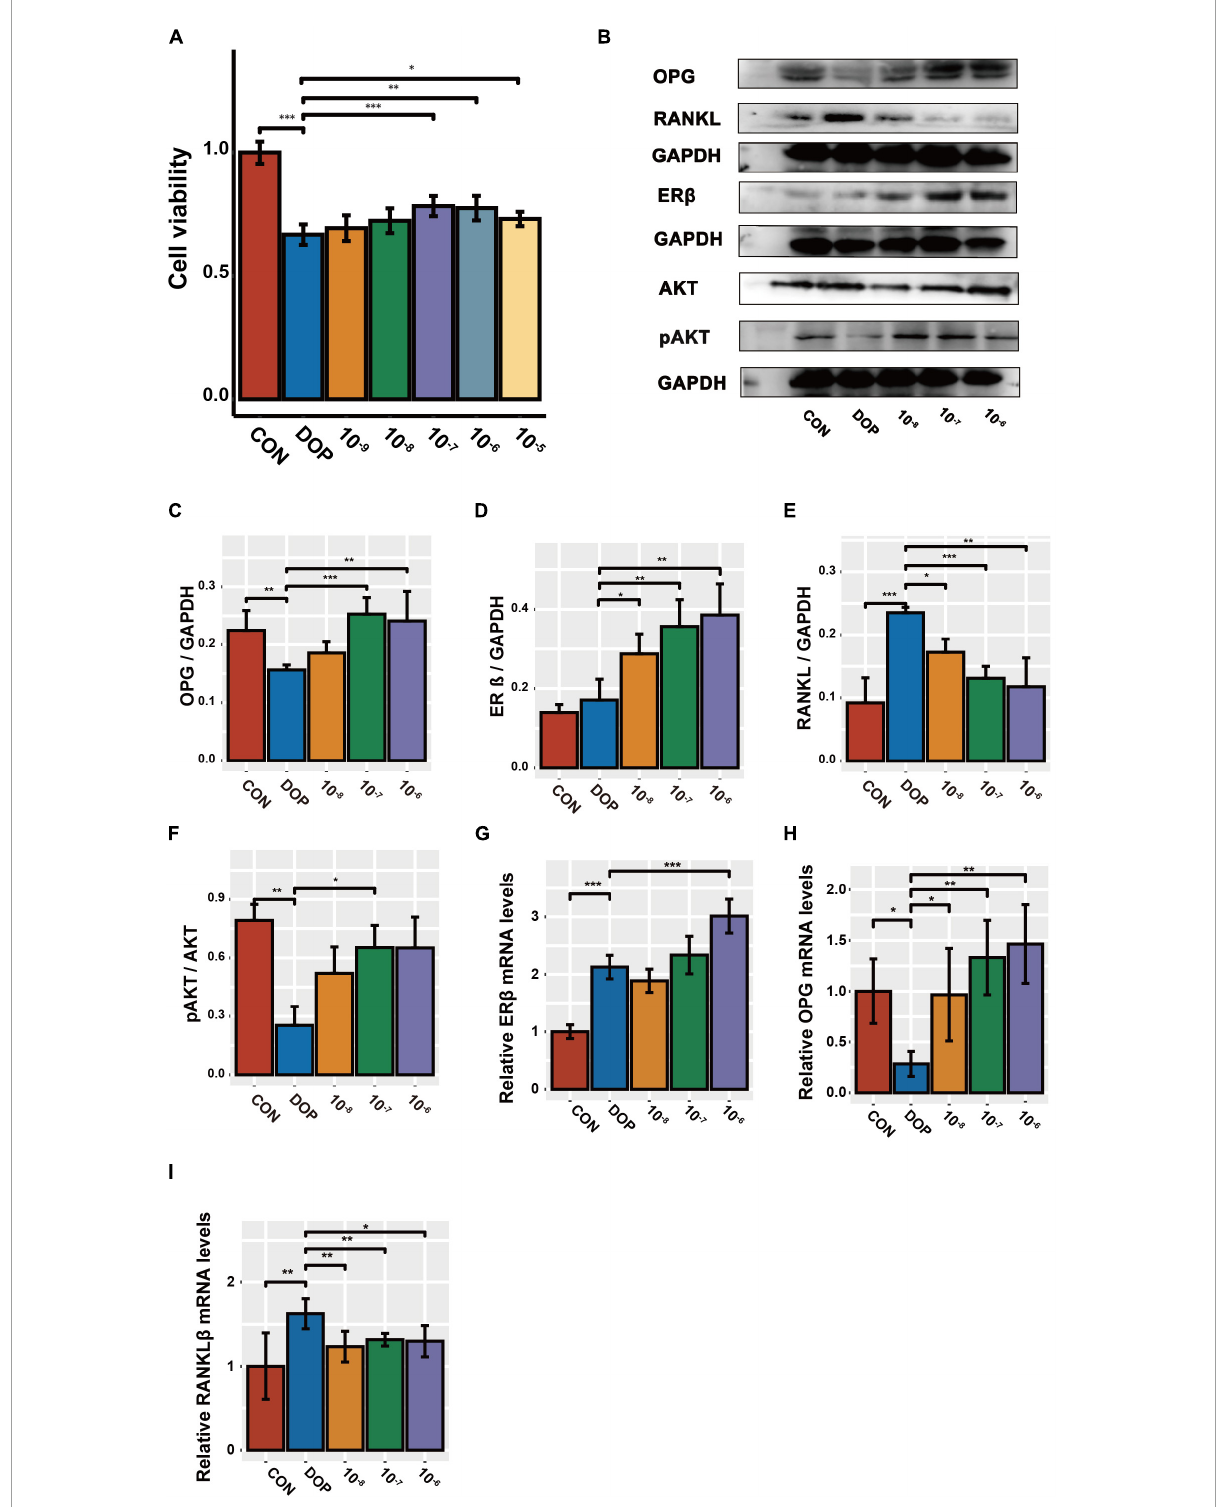
FIGURE7 The effect of S-Equol on Pi3K/AKT signaling pathway and OPG/RANKL ratio in ROS17/2.8 cells. (A) After 48 h of S-Equol intervention, cell viability was detected by CCK8 assay; (B–F) The expression of OPG, RANKL, ER β , and pAKT/AKT was analyzed using the western-blot method. (G–I) The amount of mRNA of OPG, RANKL, and ER β was analyzed using the RT-PCR method. All data are expressed as the mean ± SD ( n = 5). * p < 0.05, ** p < 0.01, *** p < 0.001 as compared to the diabetic osteoporosis (DOP)